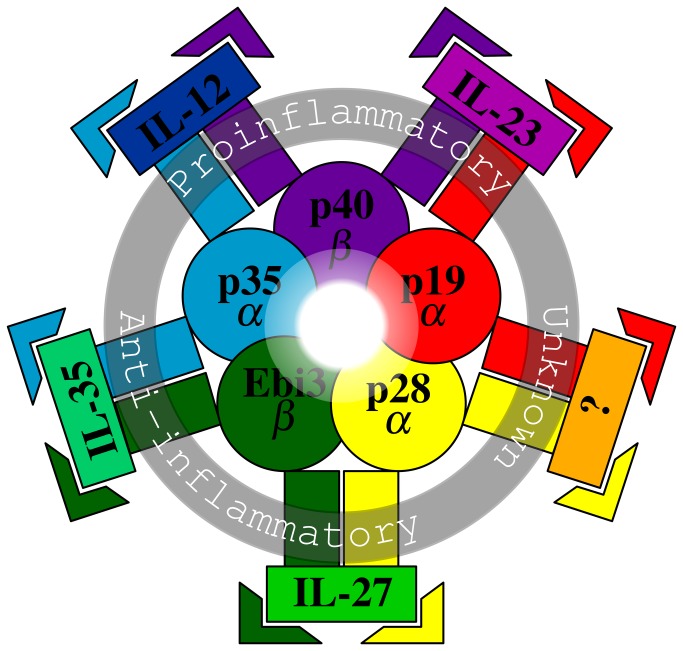
Schematic diagram of IL-12 family.The diagram illustrates the currently known 5 chains (the innermost zone), composite cytokines with their proposed functions (the middle zone), and their receptors (the outermost zone). The five color-coded chains are either α chains (p19, p35, and p28) or β chains (p40 and Ebi3). Each functional cytokine is made of one α and one β chain. IL-12 (p35/p40) is a proinflammatory Th1 activator and stabilizer. Similarly, IL-23 (p19/p40) is a proinflammatory Th1 activator and Th17 stabilizer. On the other hand, IL-27 (p28/Ebi3) is an immunoregulatory cytokine mainly with an anti-inflammatory capacity. IL-35 (p35/Ebi3) is again anti-inflammatory and secreted by Treg cells. Therefore, the four cytokines with their divergent functions can promote a representative model of the immunological spectrum ranging from inflammation to tolerance. The unknown cytokine is a theoretical one and symbolizes the possibility of unraveling other unknown family members in the future. Each chain (p19, p40, p35, Ebi3, p28) binds to its specific receptor (IL23R, IL12RB1, IL12RB2, IL6ST, and IL27RA, respectively) and is coded with the same color of the corresponding chain (receptor names are not shown). Typically, a composite cytokine would require a β chain receptor for high affinity binding and an α chain receptor for signal transduction. For alternative terminology of IL-12 family members refer to Table 1.